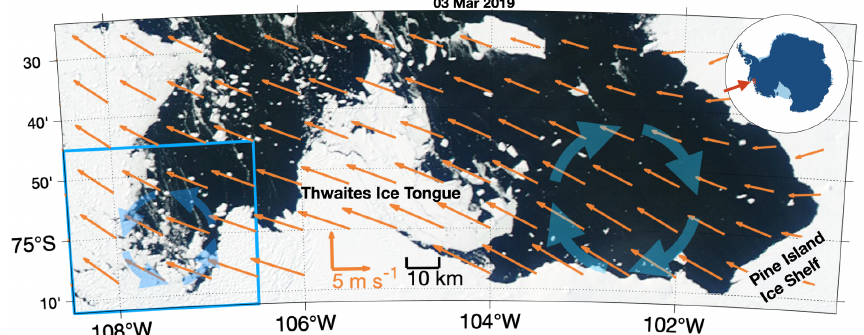
Figure 1. Map of the southeastern Amundsen Sea. Schematics of Pine Island Bay and Thwaites gyres are shown by thick blue arrows in front of Pine Island Ice Shelf and to the west of Thwaites Ice Tongue, respectively. The ice imagery is from Worldview Aqua/MODIS corrected reflectance (true colour) on 3 March 2019. The climatological 10m wind velocity from 2009–2019 ERA5 reanalysis (Hersbach et al., 2018) data (0 . 25 ◦ × 0 . 25 ◦ resolution; wind velocity data are interpolated to 0.25 ◦ × 0 . 125 ◦ resolution. Only every other arrow in the zonal direction is plotted for clarity) is denoted by orange arrows (see orange scale vectors). The blue box covers the region of Thwaites gyres that is used for Figs. 2 and 4. The inset map shows our study region.